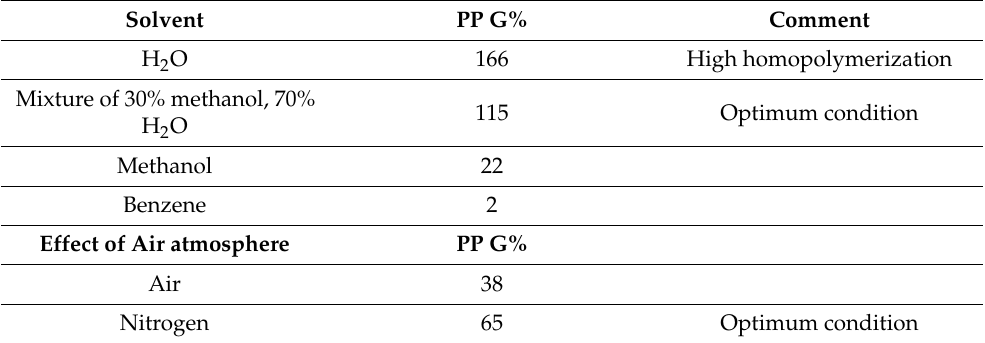
Table 1. Effect of inhibitor concentration (g/L) on the degree of graft of AN/AAC on PP